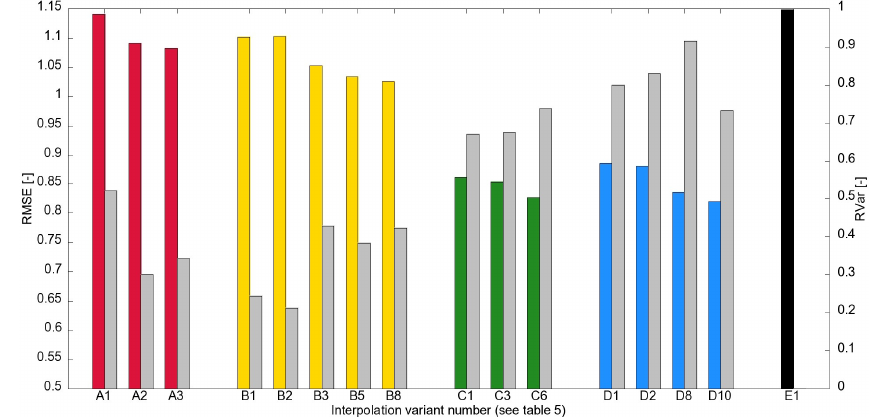
Fig. 7. Precipitation cross-validation results using all summer events averaged over time steps with average precipitation exceeding a threshold of 1mmh − 1 for selected interpolation methods (red bars: univariate methods; yellow bars: KED without radar; green bars: KED with radar reflectivities; blue bars: KED with radar rainfall intensities; grey bars: RVar coefficient, black bar: radar rainfall intensities only).